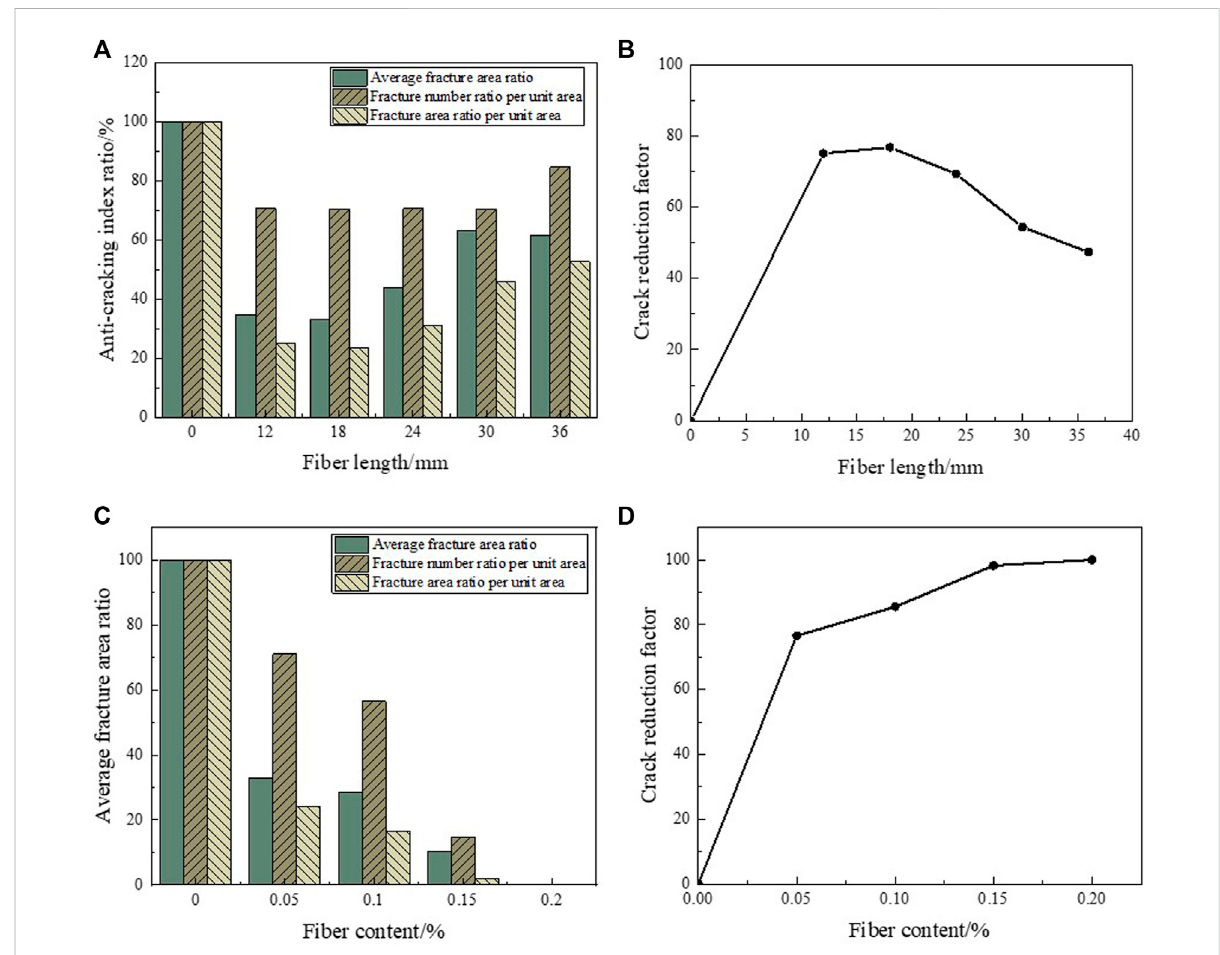
FIGURE 5 Comparison ofcrackparametersofbasalt fi berreinforcedconcretewithconcreteofdifferentlengthanddifferentvolumecontentofBF(Wang et al., 2017) (A) Anti-cracking index ratio in fl uenced by fi ber length (B) Crack reduction factor in fl uenced by fi ber length (C) Anti-cracking index ratio in fl uenced by fi ber content (D) Crack reduction factor in fl uenced by fi ber